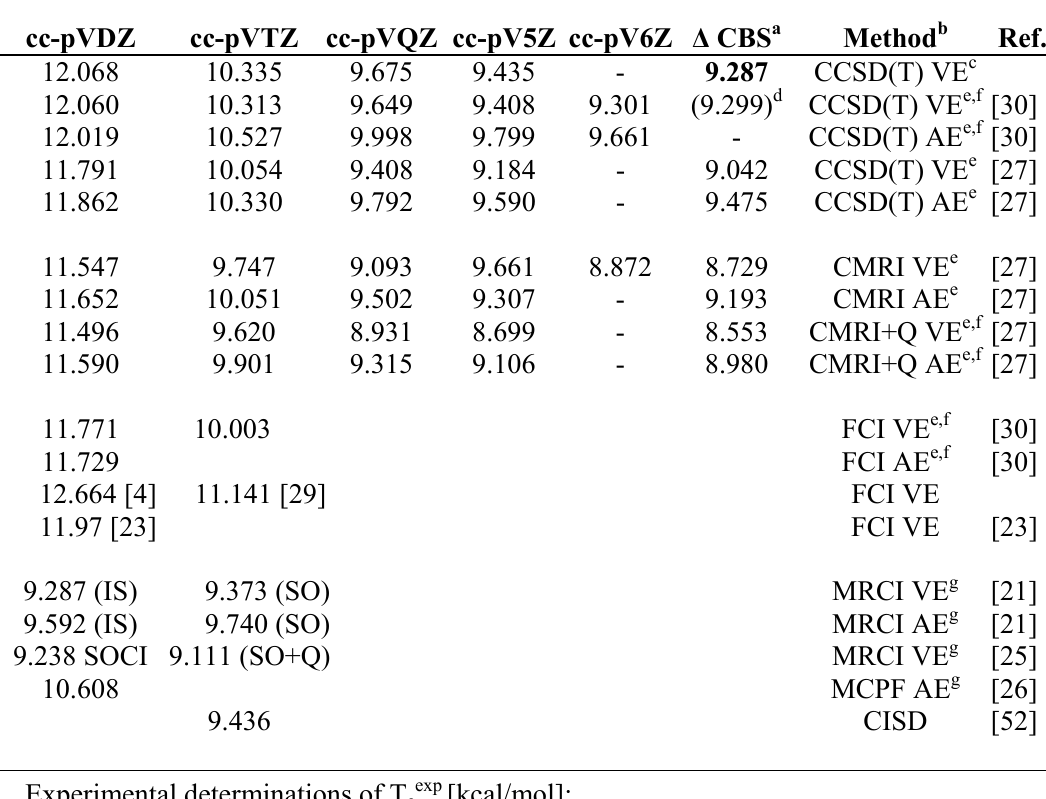
Table 6. Adiabatic singlet–triplet separation energies (T Tables 1 and 2, referring to minima of potential energy curves without vibrational corrections (1 Hartree = 627.5095